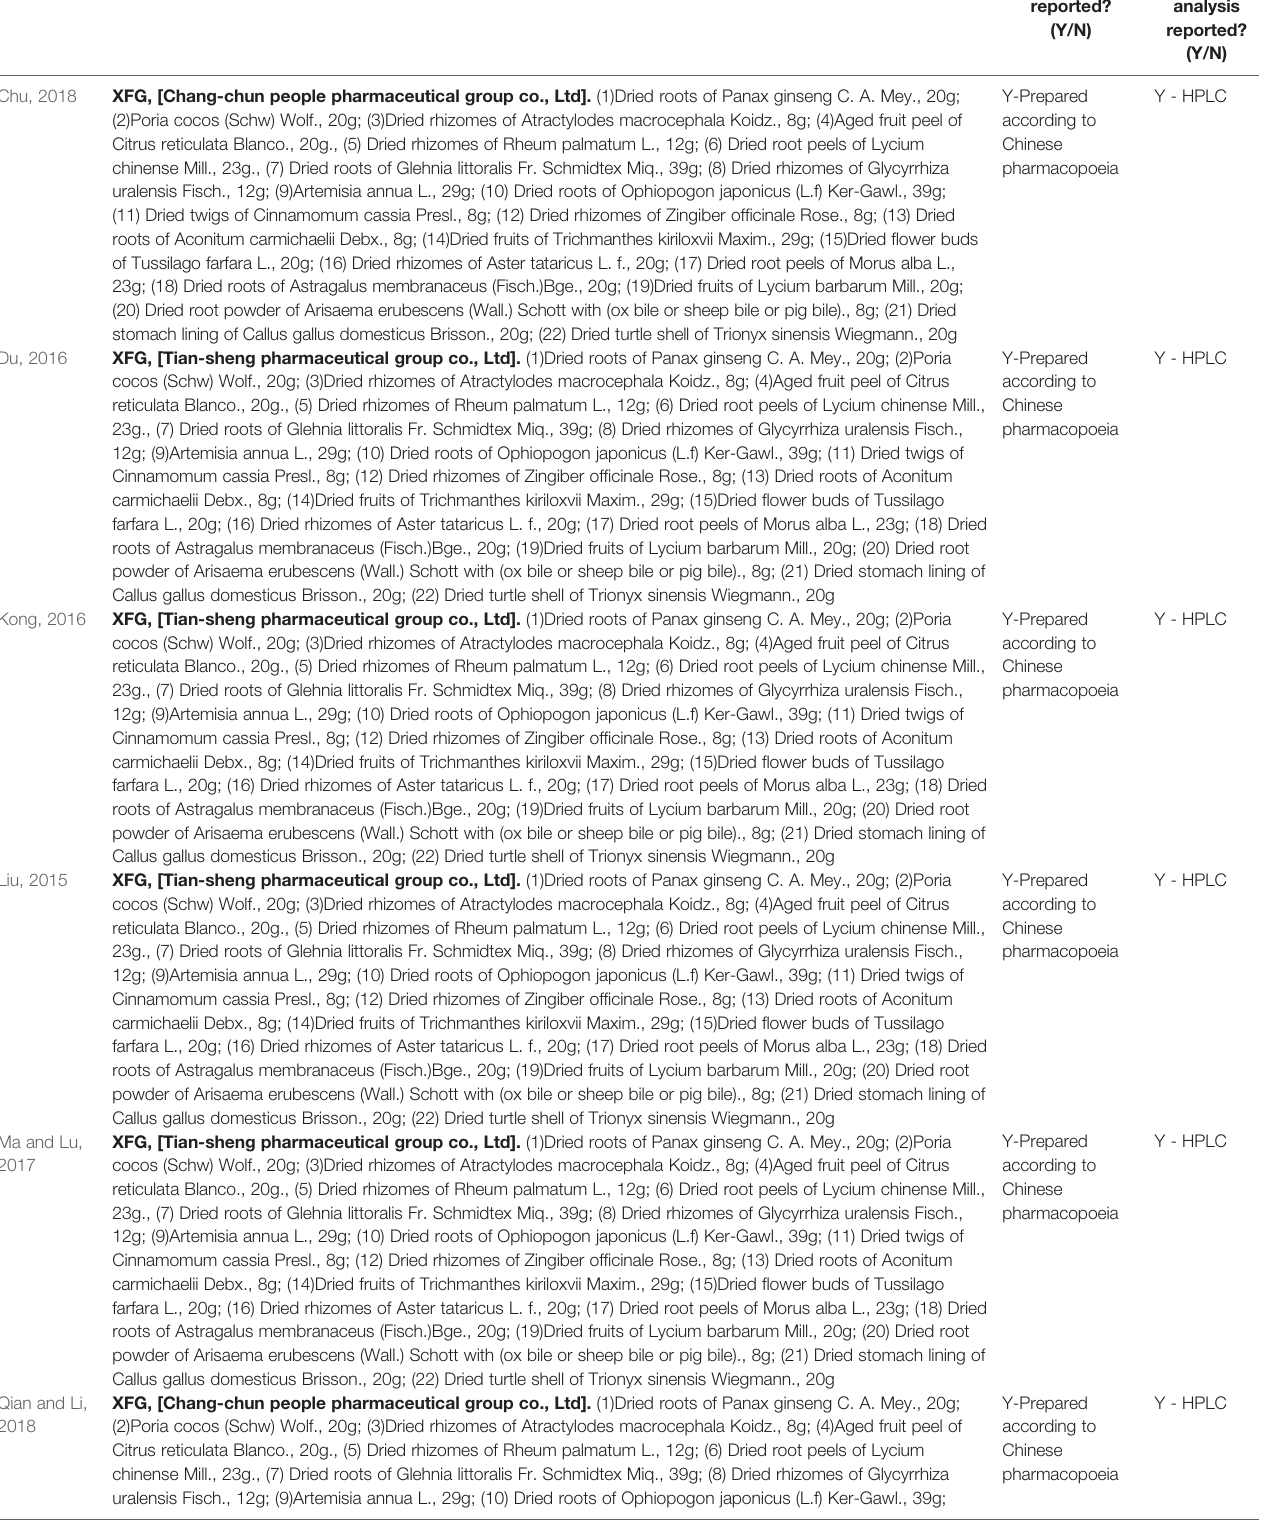
TABLE 4 | The general characters of XFG. Study Formulation, Source, Species, concentration Quality control